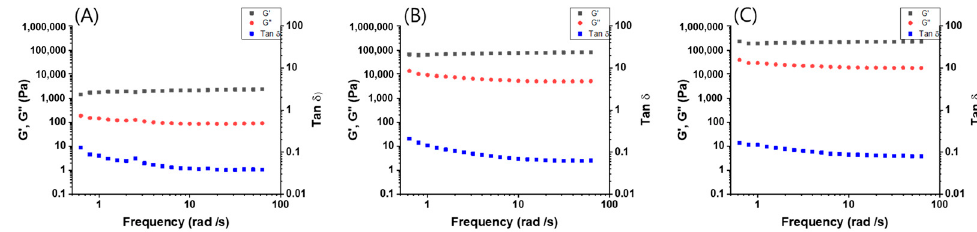
Figure 5. Frequency sweep of gels obtained from ( A ) 1 (1 wt %) + 2 (2 equiv.), ( B ) 1 (3 wt %) + 2 (2 equiv.) and ( C ) 1 (5 wt %) + 2 (2 equiv.) in toluene.